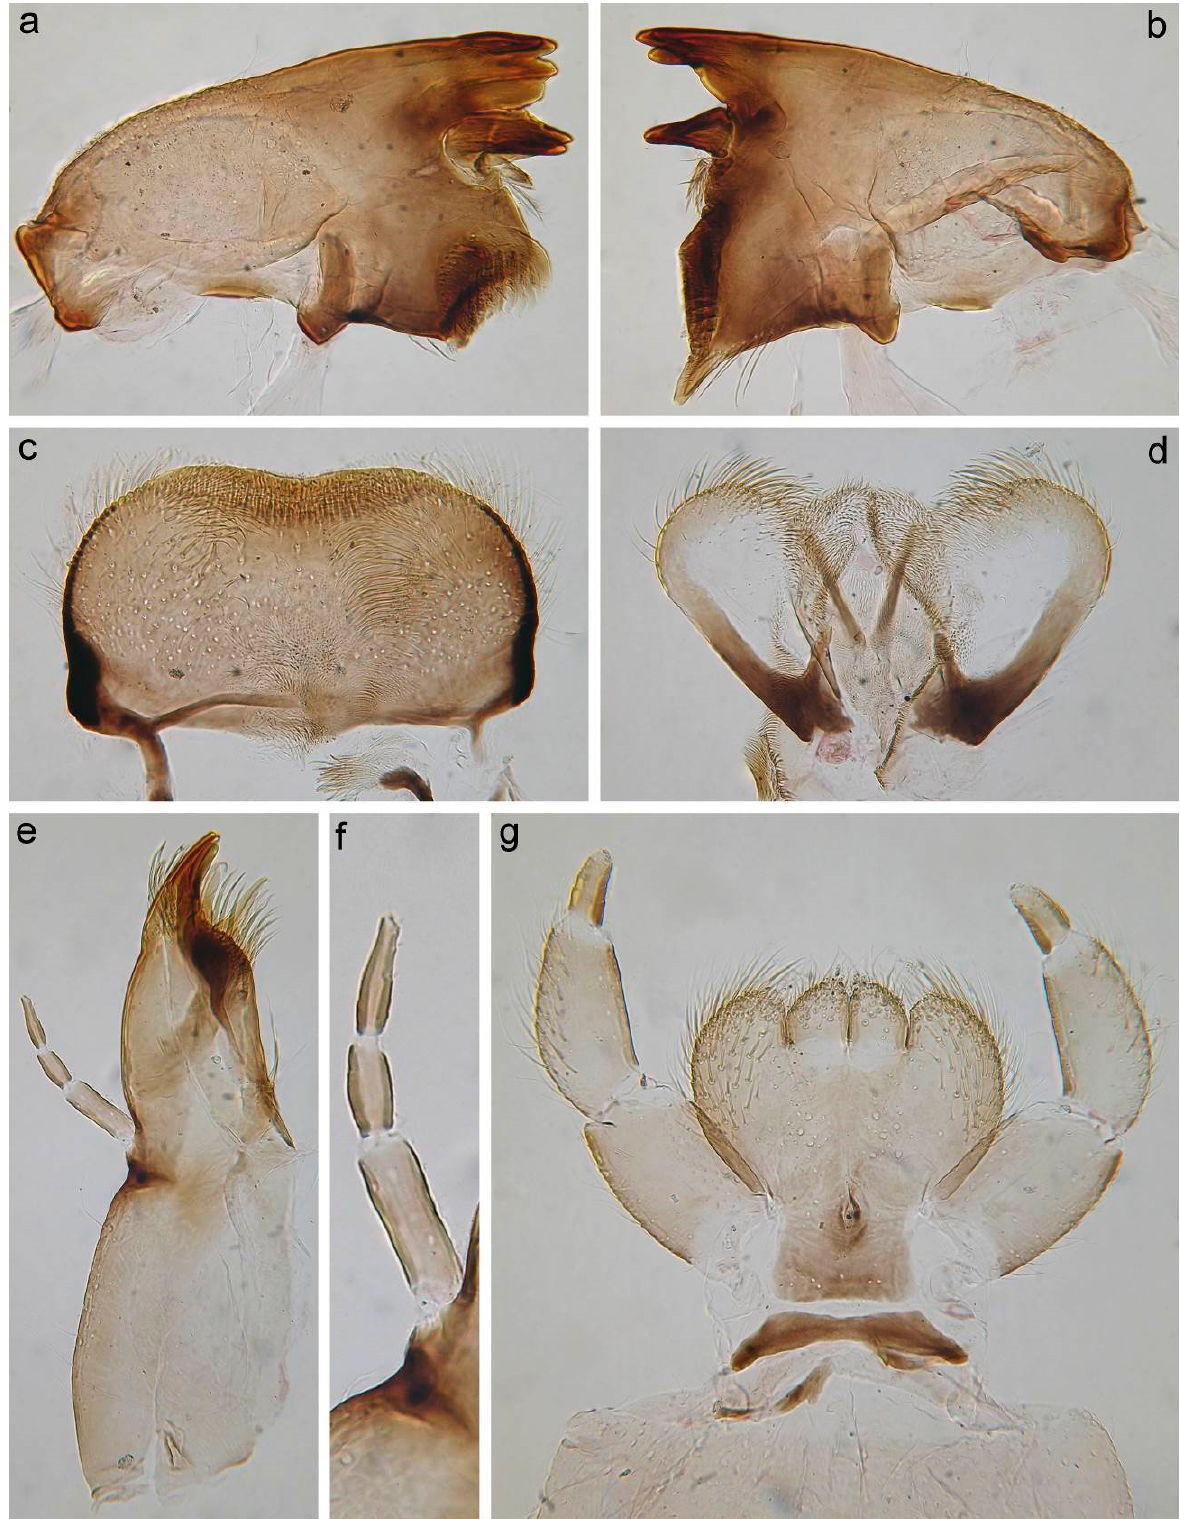
Figure 7. Larva of Torleya elissa (Jacobus, Zhou & McCafferty, 2009). ( a ) Angulate mandible, ( b ) planate mandible, ( c ) labrum, ( d ) hypopharynx, ( e ) maxilla, ( f ) maxillary palp, ( g ) labium.